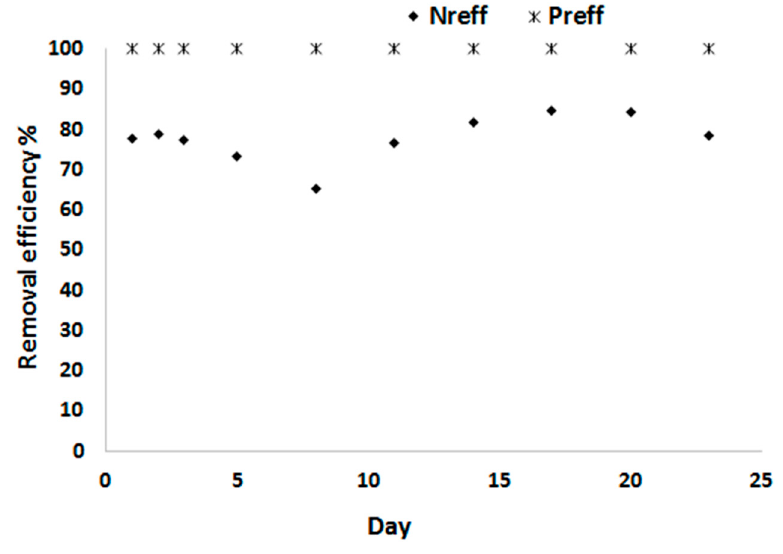
Figure 10. N and P removal efficiency of C. sorokiniana.